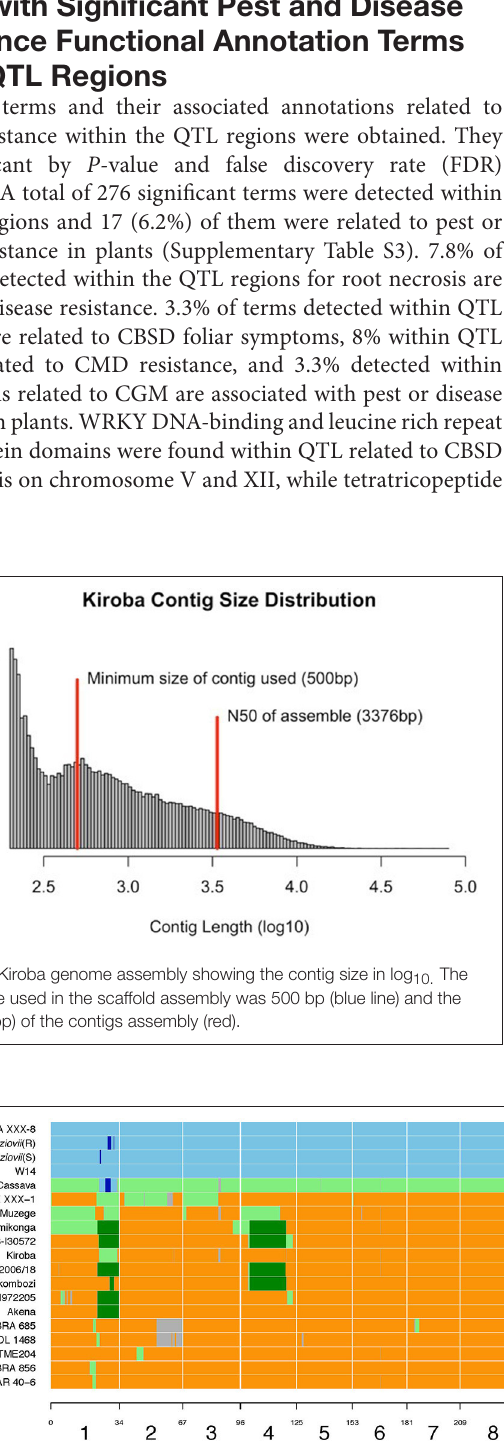
Frontiers in Plant Science |